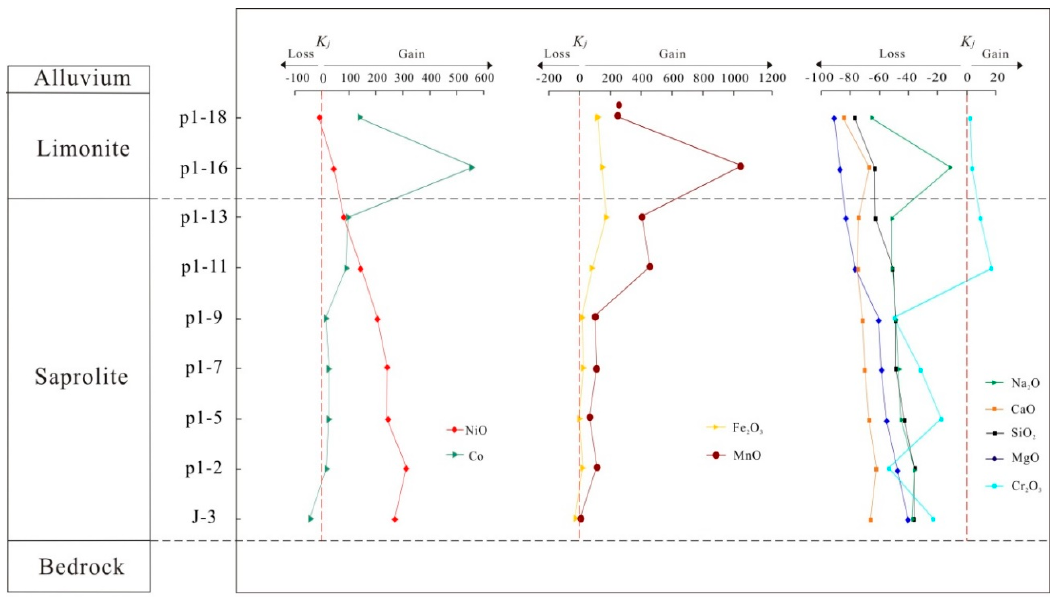
Figure 10. Results of the geochemical mass-balance calculations of some representative elements along the profile.